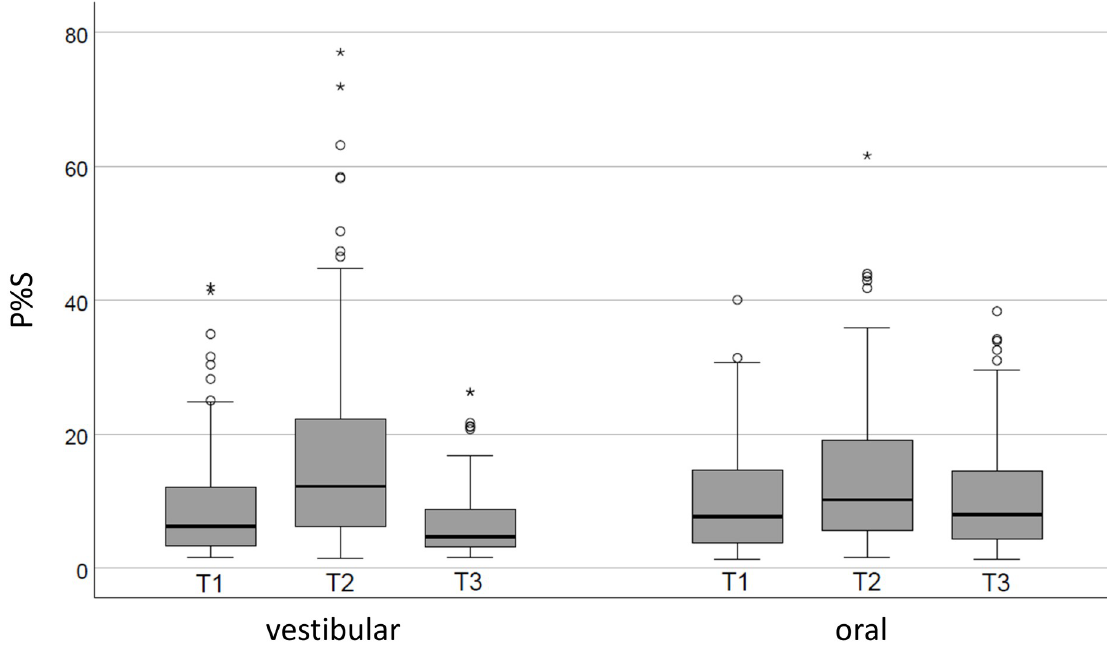
Fig 5. P%S values at T1 (baseline), T2 (after 48 h abstaining from oral hygiene) and T3 (after tooth brushing) are shown for the oral and vestibular surfaces of the Ramfjord teeth. Boxplots showing the minimum value, first quartile, median, third quartile, and maximum value. Circles indicate outliers (values more than 1.5 � IQR above the upper quartile (Q3) or below the lower quartile (Q1)), asterisks indicate extreme values (values more than 2.5 � IQR above the upper quartile (Q3) or below the lower quartile (Q1)).